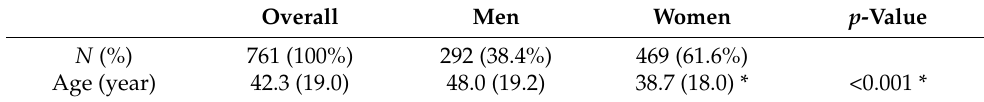
Table 1. Demographics and study outcomes. Overall Men Women p -Value